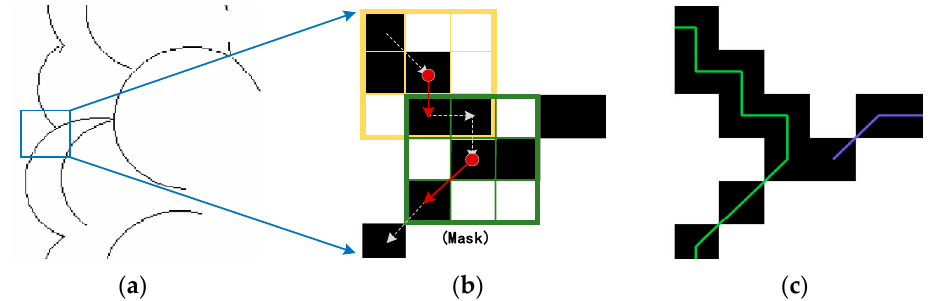
Figure 5. An example of edge contour segmentation algorithm of berries. ( a ) stands for binary graph; ( b ) stands for local image, the red dot is the center of the mask, and the red and gray arrows indicate the search direction; ( c ) Search results with different colors representing edge contours.